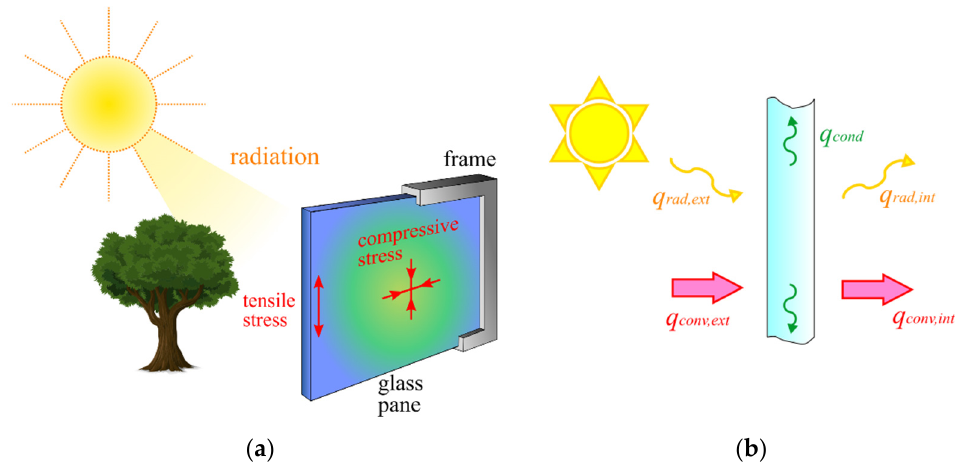
Figure 1. Schematics of ( a ) typical thermal boundaries for a glass window and ( b ) heat exchange phenomena occurring in a glazing panel due to climatic actions.